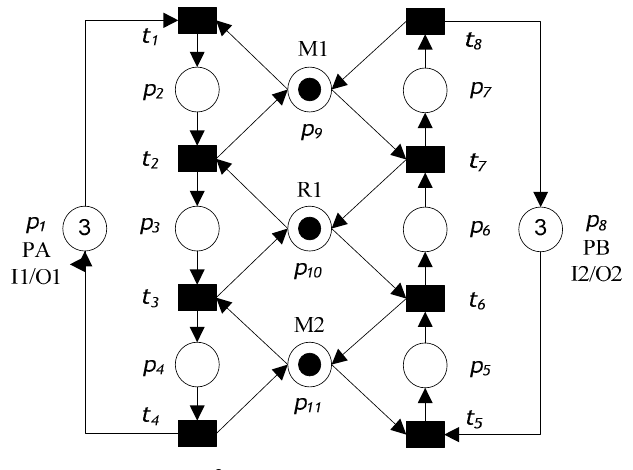
Figure 1. S 3 PR Petri net model of an AMS.